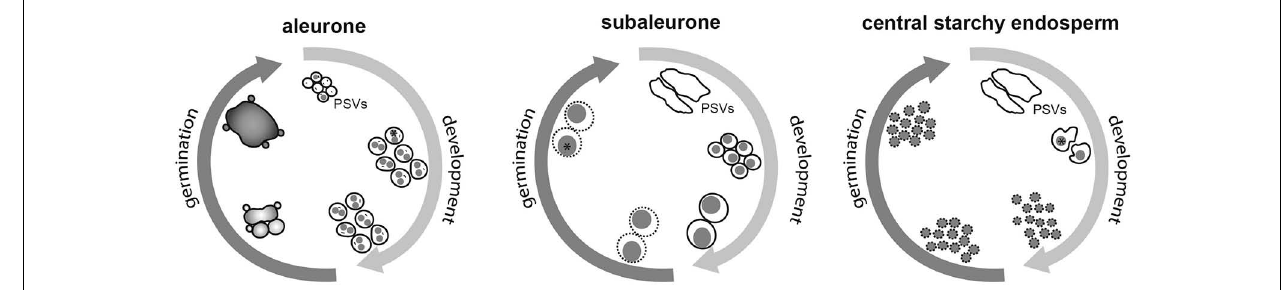
FIGURE 3 | Schematic overview of the spatiotemporally regulated dynamics of storage organelles in cereal seeds during development and germination. The spherical PSVs in the aleurone remain constant throughout seed maturation. Note the presence of zein-rich protein inclusions (asterisk) and intravacuolar membranes (indicated as short black lines). Upon germination, GA 3 -dependent vacuolation results in the formation of one large central vacuole and secondary lytic vacuoles.The dramatic change from nutrient-storing compartments to lytic organelles is indicated by different